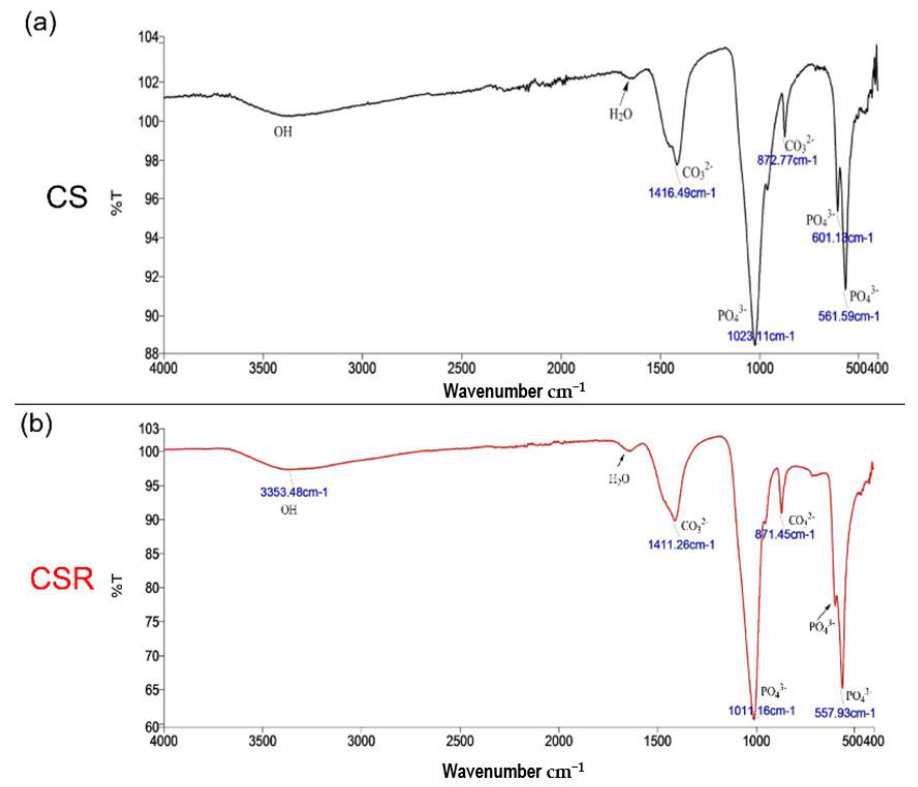
Figure 5. FTIR spectra of Cs ( a ) and CSR ( b ) after 28 d of immersion in PBS. A band split at around 525–650 cm − 1 and 1070 cm − 1 which are characteristic indicators of apatite crystals formation.